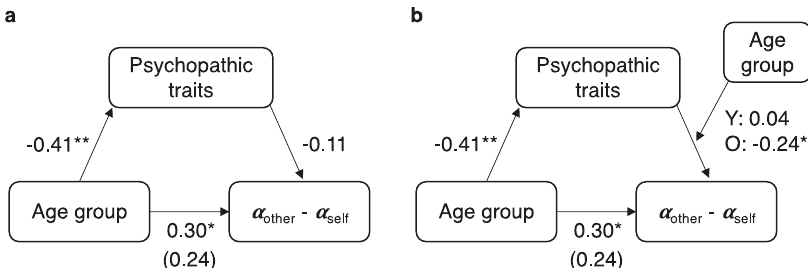
Fig. 5 Indirect effect of age group on relative prosocial learning ( α other − α self ) via self-reported psychopathic traits for older adults only. a A standard mediation model does not show evidence of an indirect effect of age group on relative prosocial learning via self-reported affective-interpersonal psychopathic traits. Although accounting for self-reported psychopathic traits means the signi fi cant direct effect of age group on relative prosocial learning (standardised coef fi cient = 0.30 [0.02, 0.57], t (146) = 2.14, P = 0.03) becomes non-signi fi cant (standardised coef fi cient = 0.24 [ − 0.04, 0.53], t (145)